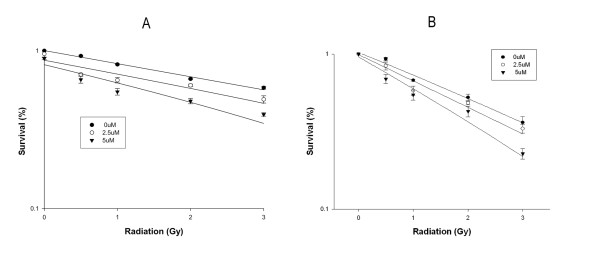
Costunolide enhances the radiosensitivity of hepatoma cells. A, HA22T/VGH cells. B, Sk-Hep1 cells. Clonogenic assay was used to estimate the survival of hepatoma cells.